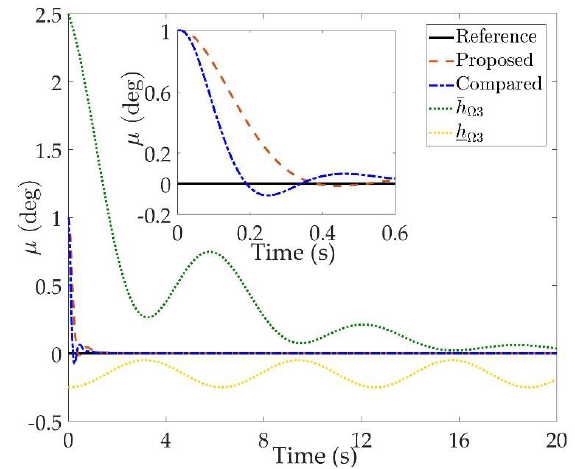
Figure 4. Comparison curves of the bank angle µ tracking performance.